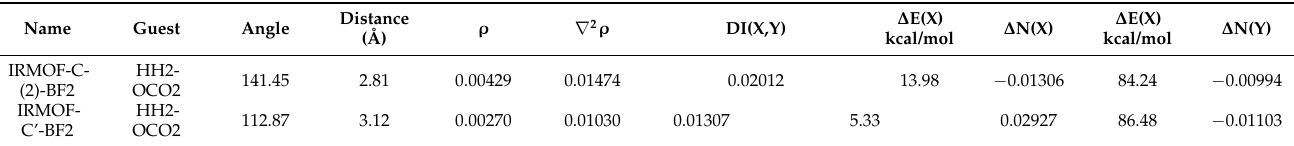
Table 13. Topological parameters of the BCP of bond in adsorption configurations of guest molecules (CO 2 and H 2 )